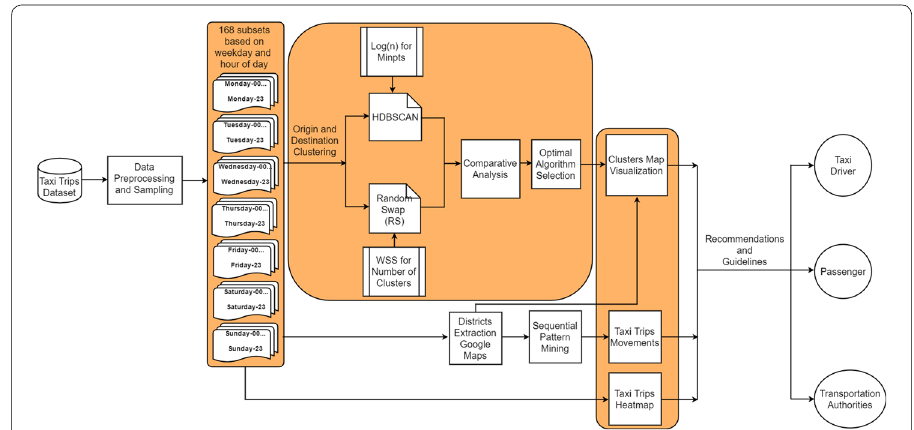
Fig. 1 Three stages system architecture